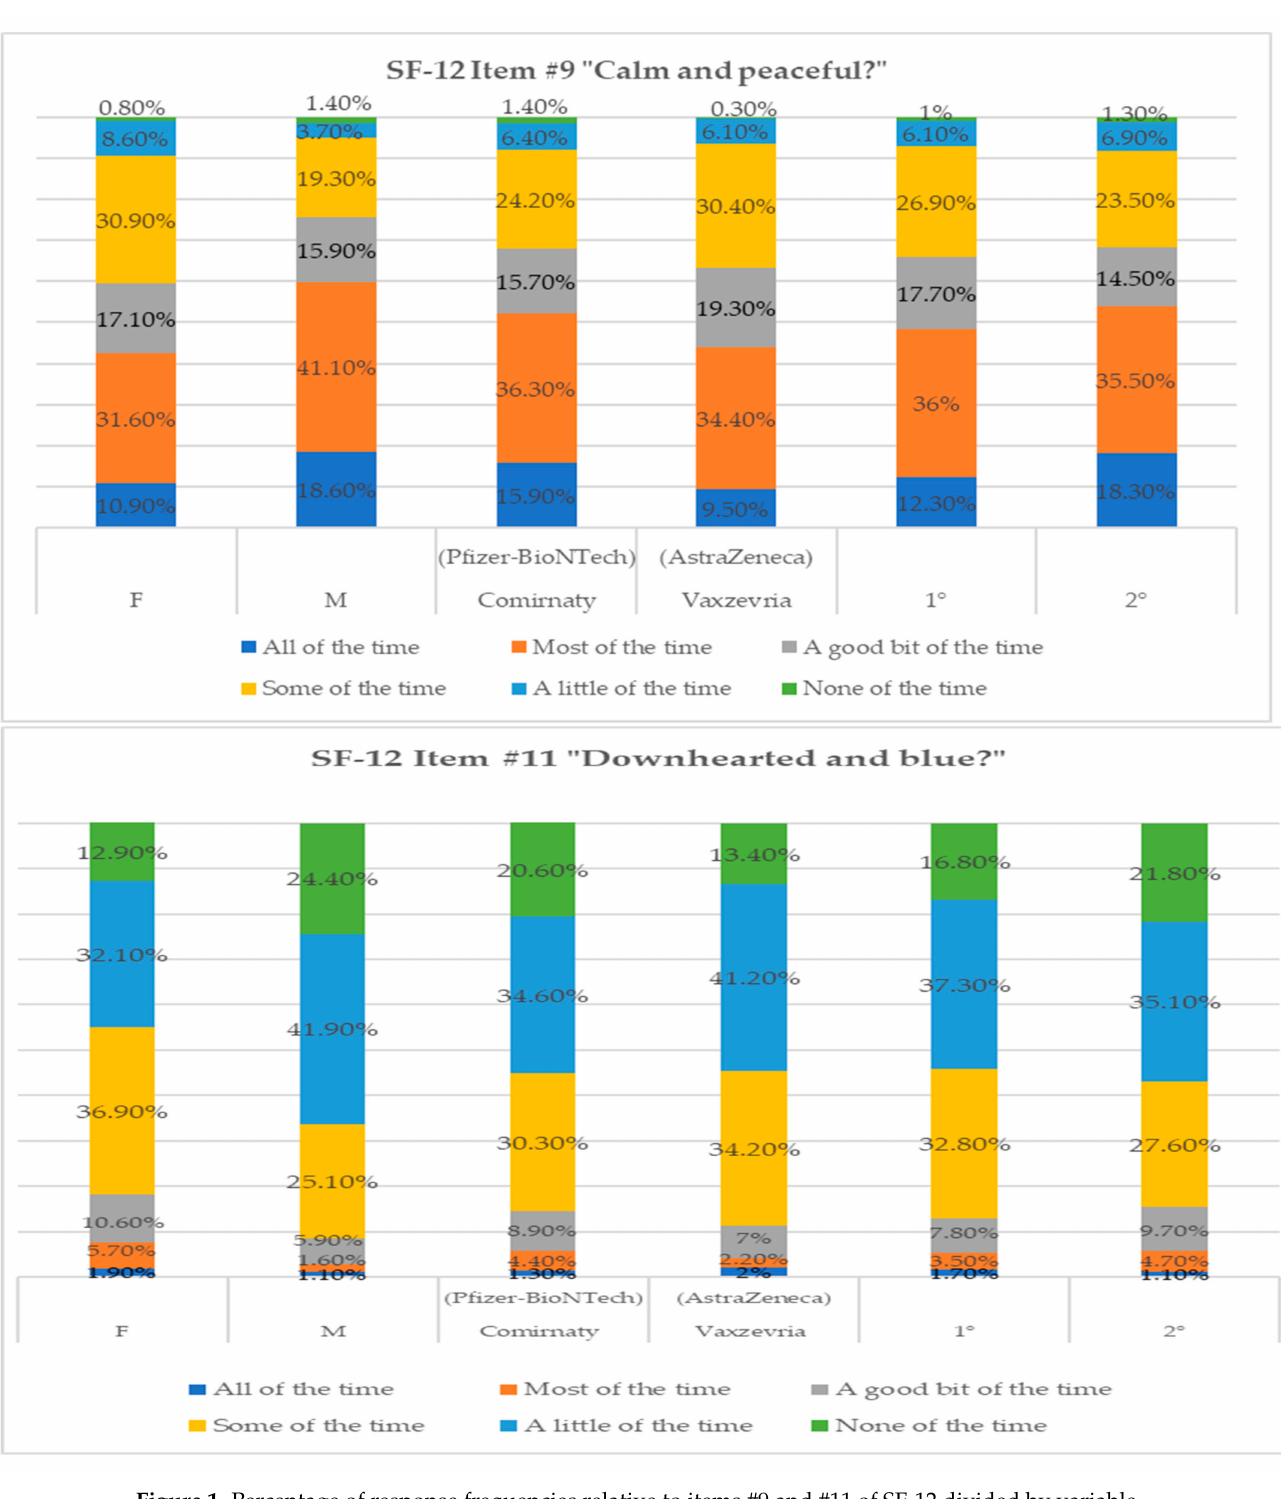
Figure 1. Percentage of response frequencies relative to items #9 and #11 of SF-12 divided by